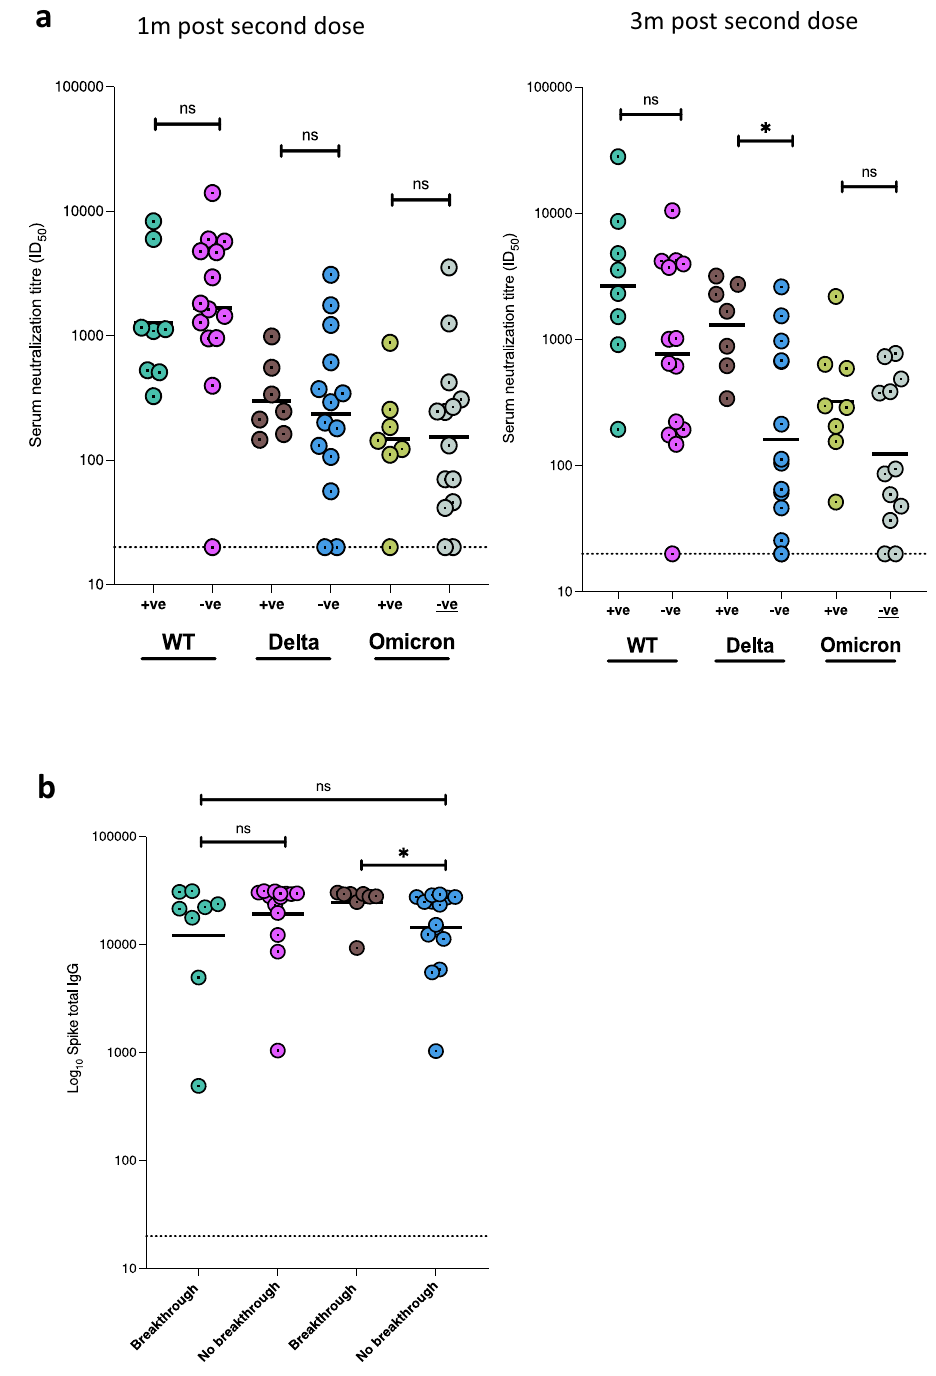
b Total anti-spike binding IgG levels in individuals with breakthrough infection between 1 and 3months post vaccination ( n =8) and with no evidence of ‘ natural ’ infection ( n =15). Data points were compared using Wilcoxon test and shown as geometric mean titre (GMT) with 95% CI. Data are representative of two indepen- dent experiments comprising of two technical replicates. * P